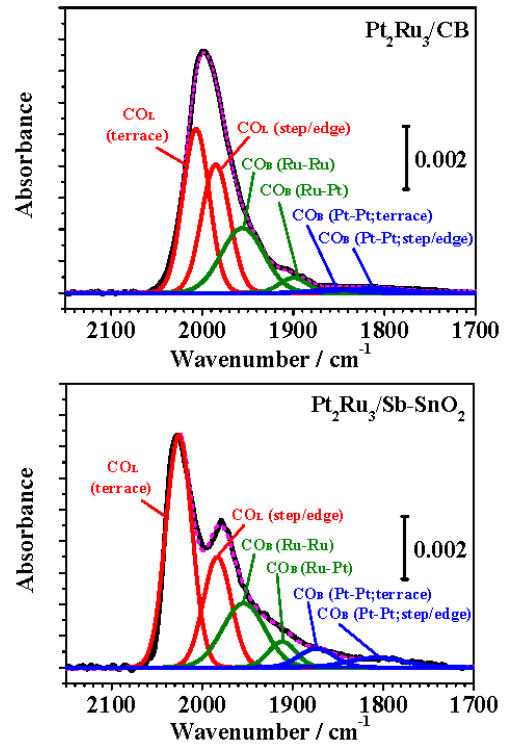
Figure 6. Deconvolution of FTIR spectra observed on Pt 2 Ru 3 /CB and Pt 2 Ru 3 /Sb ‐ SnO 2 at 0.02 V and 60 °C after 2 h of 1% CO/H 2 gas bubbling in 0.1 M HClO 4 . Curve fitting was performed for all spectra with the full width at half maximum (FWHM) fixed as a constant while allowing the peak wavenumbers and areas to vary, based on previous work (see Table S1). The CO L bands around 2020–1980 cm − 1 was deconvoluted into two components, which could be assigned to CO L on terrace and step ‐ edge sites, respectively. The CO ‐ Ru bands around 1960–1900 cm − 1 were deconvoluted into two components, which were assigned to CO B on Ru ‐ Ru and Ru ‐ Pt sites, respectively. The CO B (Pt ‐ Pt) bands around 1850–1790 cm − 1 were also deconvoluted into two components, which could be assigned to CO B (Pt ‐ Pt) on terrace and step ‐ edge sites, respectively. These spectra were normalized with respect to the total intensities of peaks assigned to CO L , I [CO L ]; ( ‐‐‐‐‐‐‐ ) experimental spectrum, ( ) sum of six peaks, ( ) CO L peaks, ( ) CO ‐ Ru peaks(consisting of CO B (Ru ‐ Ru) and CO B (Ru ‐ Pt)), and ( ) CO B (Pt ‐ Pt) peaks.